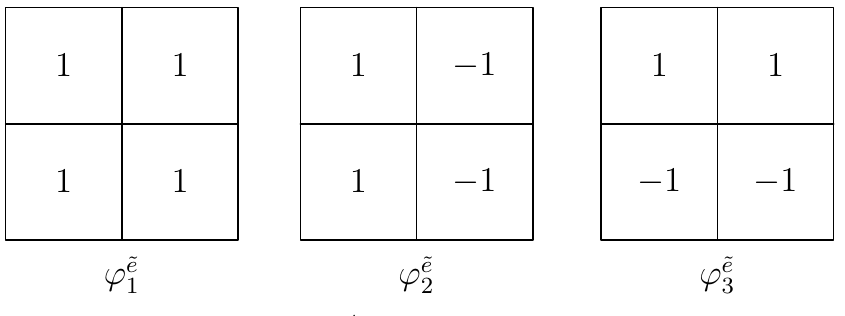
Figure 2. Local basis functions of P (cid:48)